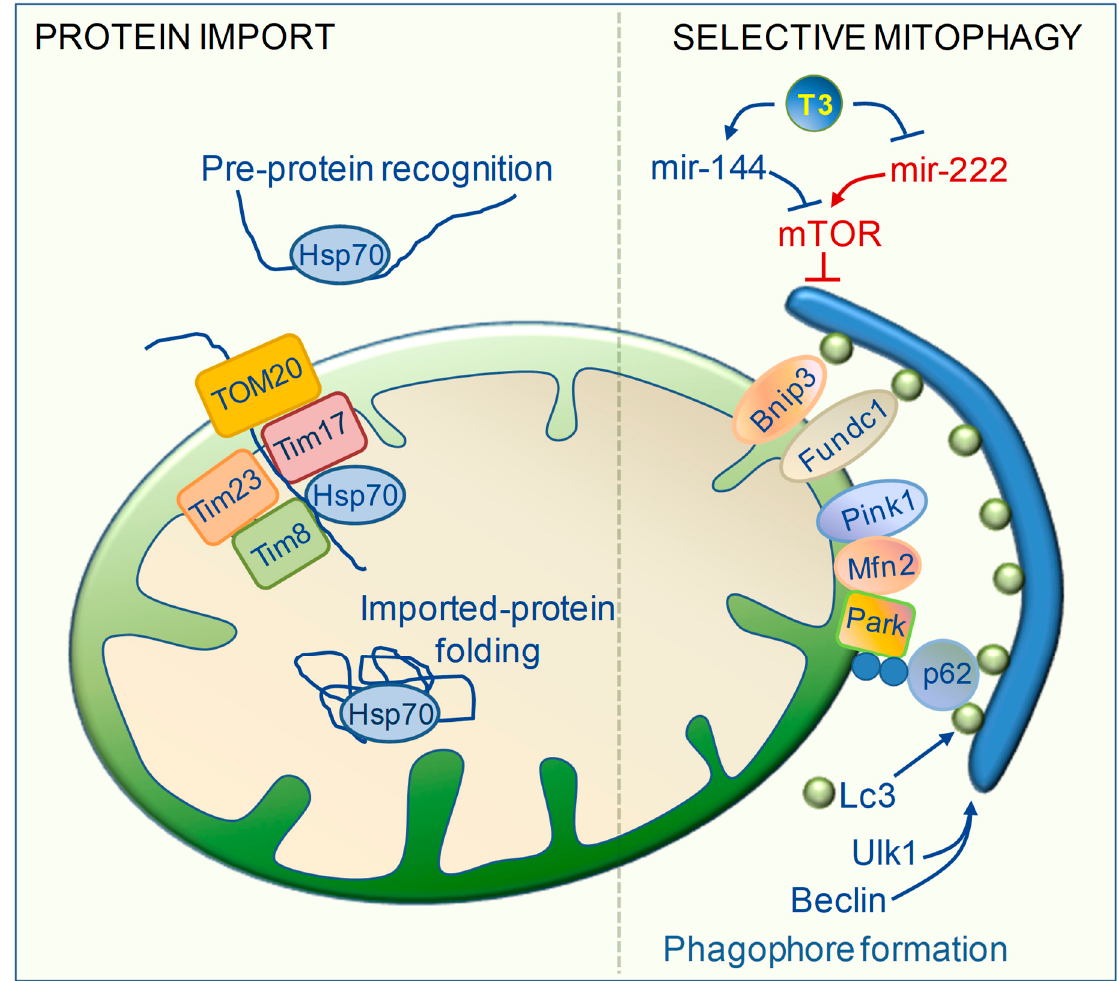
Figure 5. E ff ect of T3 on mitochondrial protein import and mitochondrial clearance. On the left, T3 enhances mitochondrial protein import by up-regulating the expression and protein levels of translocases of the outer (Tom) and inner mitochondrial membrane (Tim). Also, T3 increases the activity of Hsp70 that is involved in recognition of the mitochondrial pre-proteins, sliding of pre-proteins within translocase complexes and folding the imported pre-proteins. On the right, T3 favors the selective degradation of irreparably damaged mitochondria via mitophagy. (1) T3 up-regulates a set of molecules involved in phagophore formation and elongation including Lc3, beclin and Ulk1; (2) T3 enhances Park-dependent and independent recognition of damaged mitochondria by the Lc3 component of the phagophore; (3) T3 regulates mir-144 and mir-222 thus blunting the inhibitory effect of the mTOR pathway on the mitophagy program. (Bnip3: BCL2 interacting protein 3; Fundc1: FUN14 domain-containing protein 1; Hsp70: heat shock protein 70; Lc3: light chain3; Mfn2: mitofusin2; mTOR: mammalian target of rapamycin; p62: ubiquitin protein binding p62; Park: parkin; Pink1: PTEN induced kinase 1; Ulk1: unc-51 like autophagy activating kinase1).